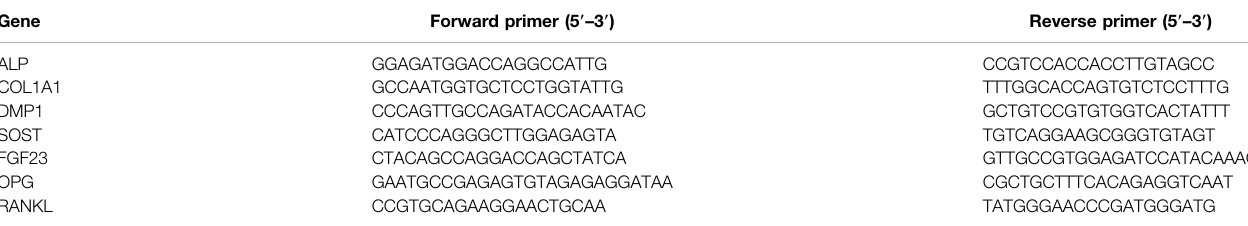
TABLE 1 | Primers sequences for